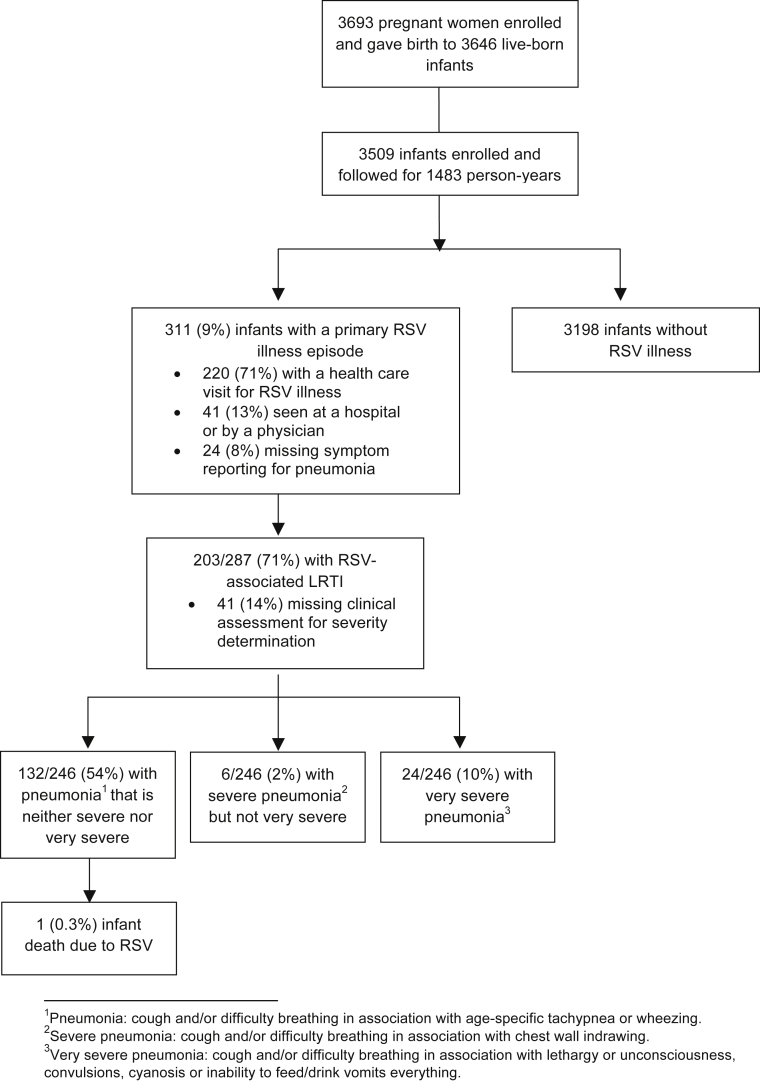
Flow diagram showing infants followed in the study from birth until 180 days of age.